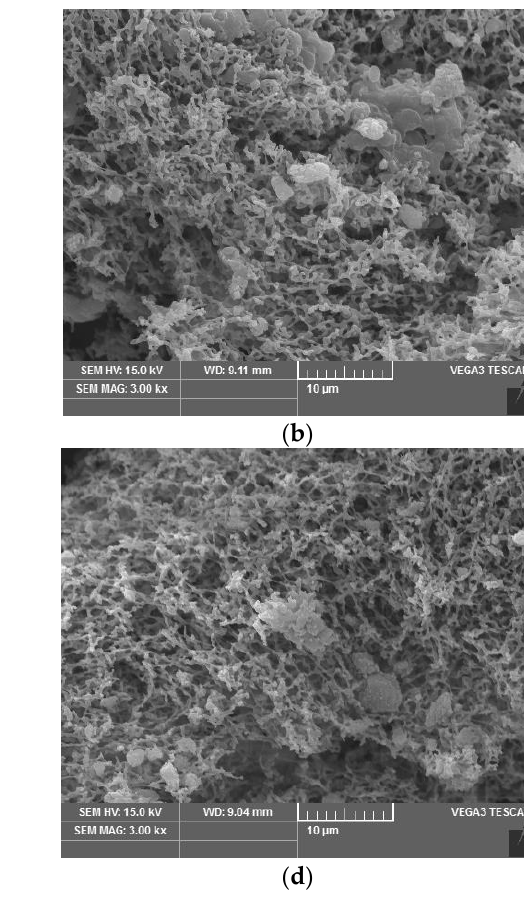
Figure 1. Infrared spectrum of Microcystis aeruginosa before and after adsorption of heavy metal ions Cu 2+ , Cd 2+ , Ni 2+ .